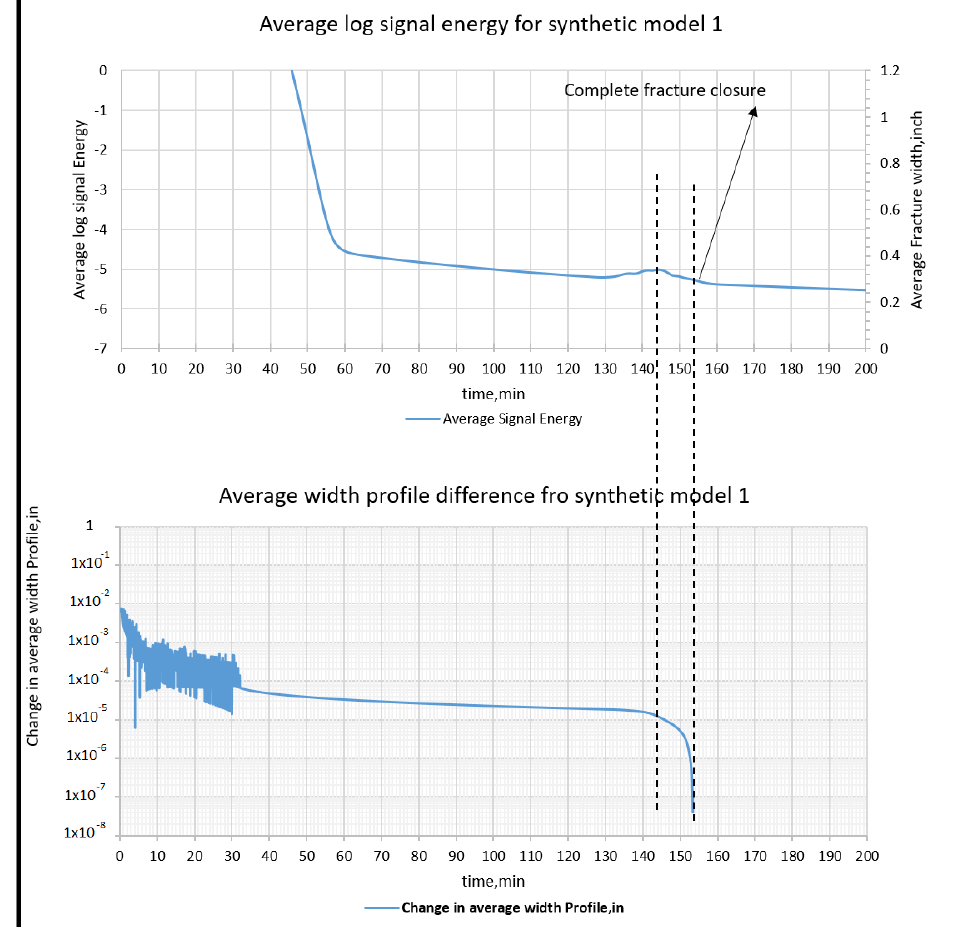
Figure 11. Comparison between the change in average width profile and CWT closure detection technique plot.